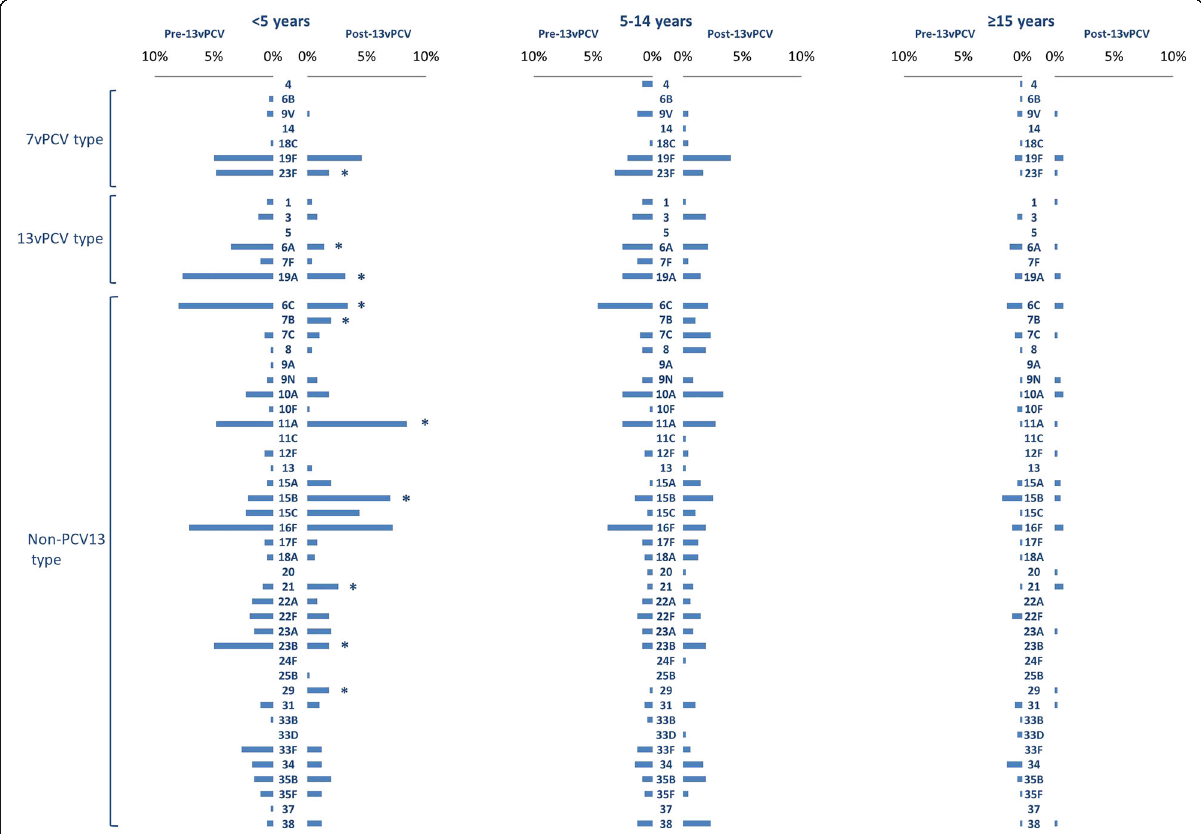
Fig. 2 Prevalence of serotypeable isolates by age group, pre- and post-PCV13 introduction (1 July 2011), among Aboriginal people in Western Australia, August 2008 to November 2014. * p <